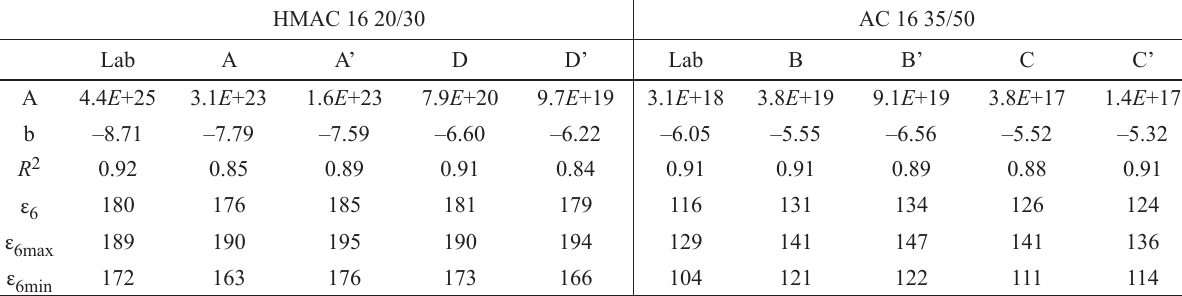
Table 4. Results of the fatigue tests carried out on mixes HMAC 16 20/30 and AC 16